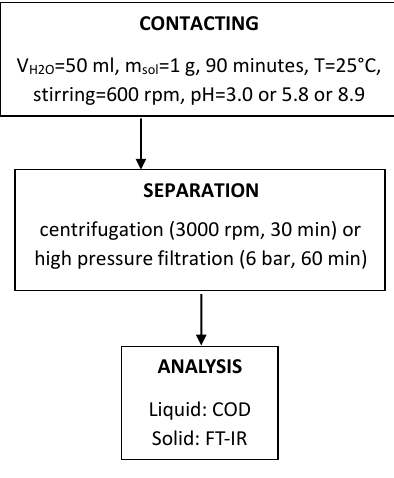
Figure 1. Flow chart of release test procedure.